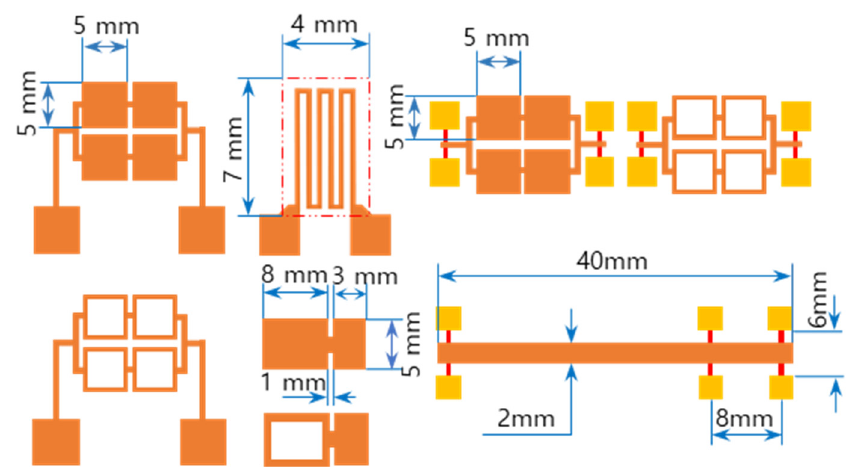
Figure 1. Different integrated reactive multilayer systems (iRMS) pattern shapes used for the observation of reaction propagation behavior (the initiation of the iRMS ignition using a Joule heating effect can be carried out by the application of the DC bias current either directly on the reactive pads or through gold contacts (yellow pads) connected with a titanium line (red